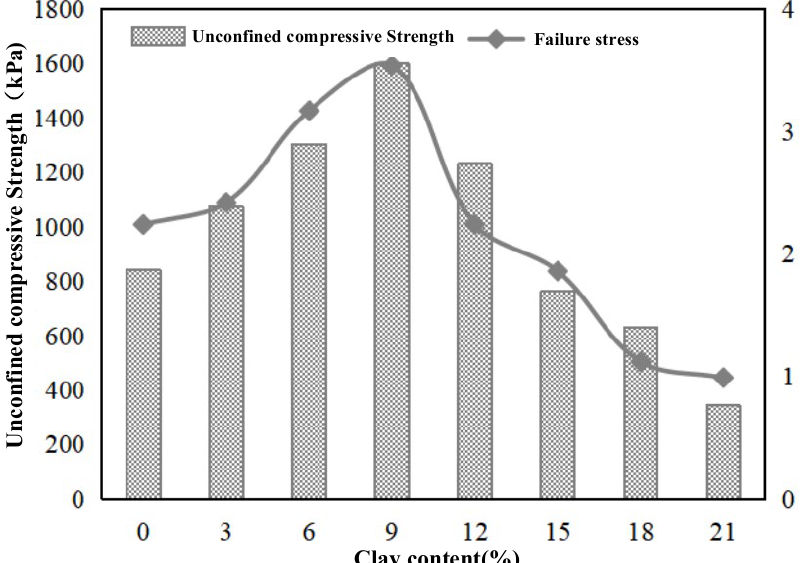
Figure 5. UCS and failure strain with different clay contents (MICP-Treat).